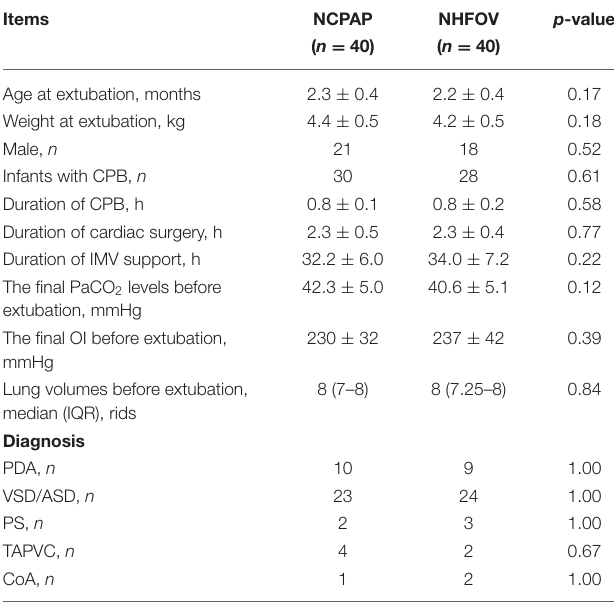
TABLE 1 | Clinical data of all